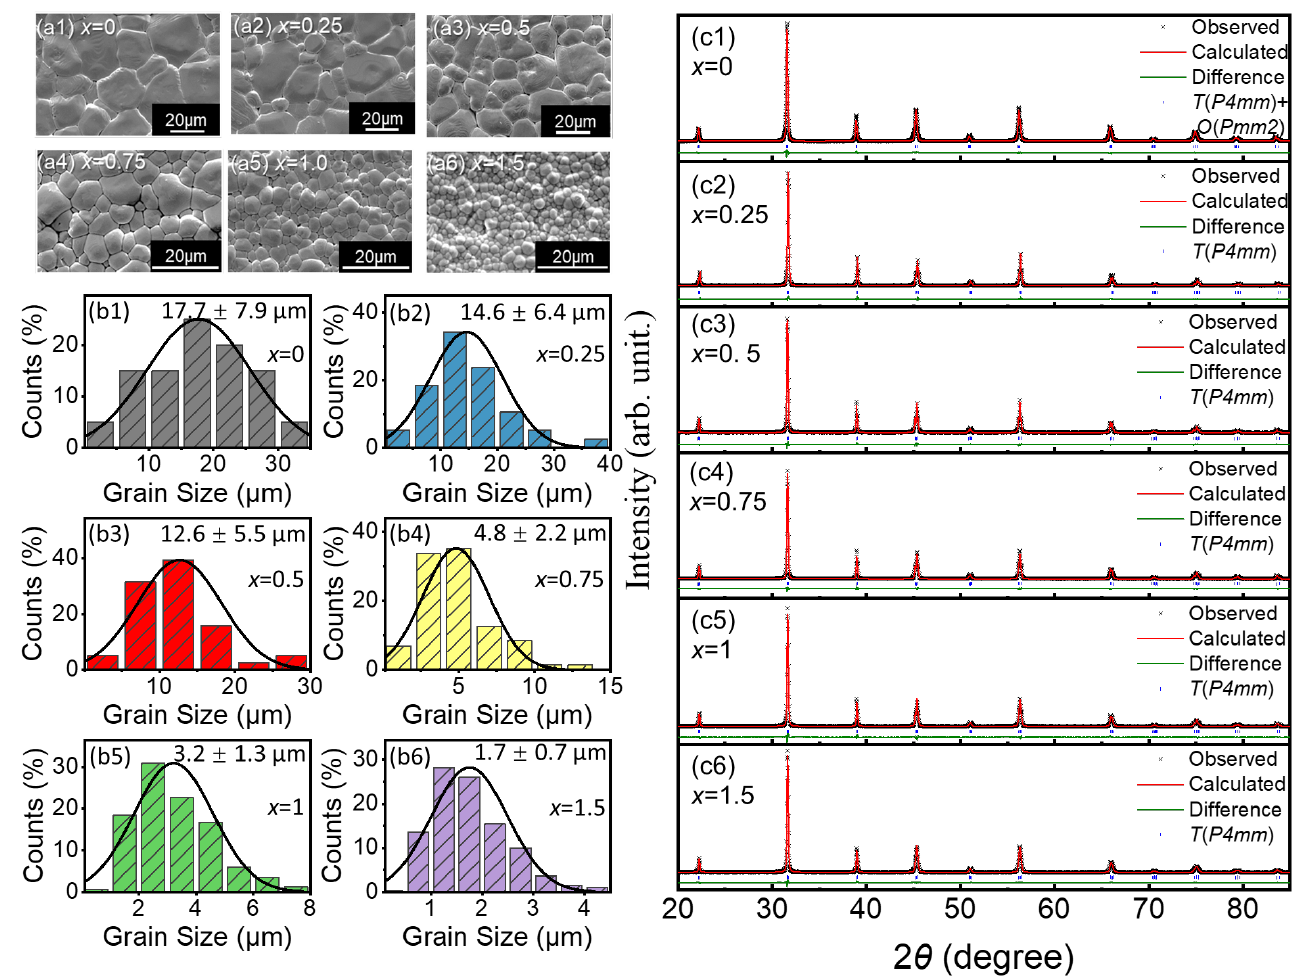
Figure 1. ( a ) SEM images and ( b ) normal distribution diagrams of the grain size statistics of BCZT- x Sm ( x = 0, 0.25, 0.5, 0.75, 1 and 1.5) ceramics; mean values and standard deviations are marked in the statistics diagram. XRD patterns and the Rietveld refinement of the XRD data for BCZT- x Sm with ( c1 ) x = 0, ( c2 ) x = 0.25, ( c3 ) x = 0.5, ( c4 ) x = 0.75, ( c5 ) x = 1, and ( c6 ) x = 1.5.